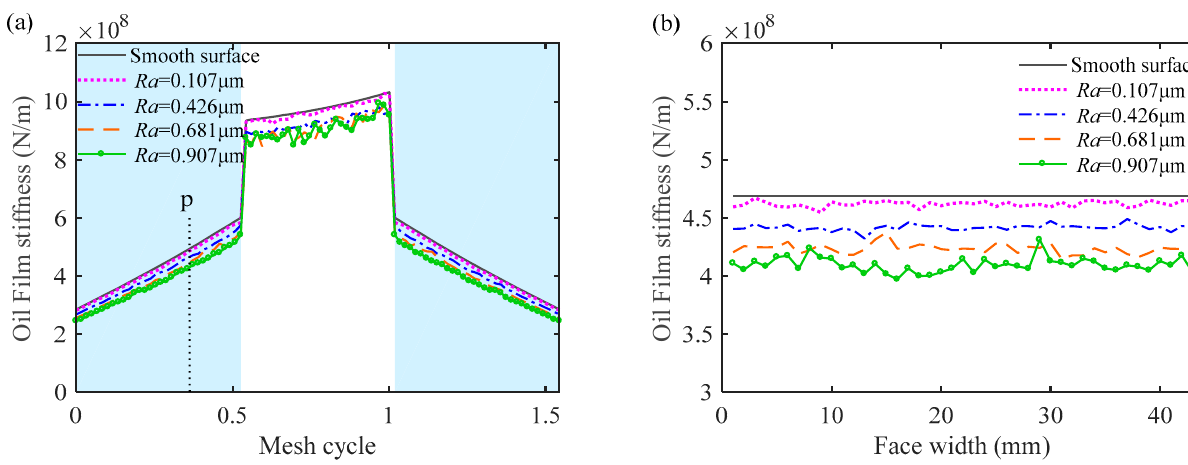
Figure 9. OFS: ( a ) along the line of action; ( b ) along face width direction at meshing position P.